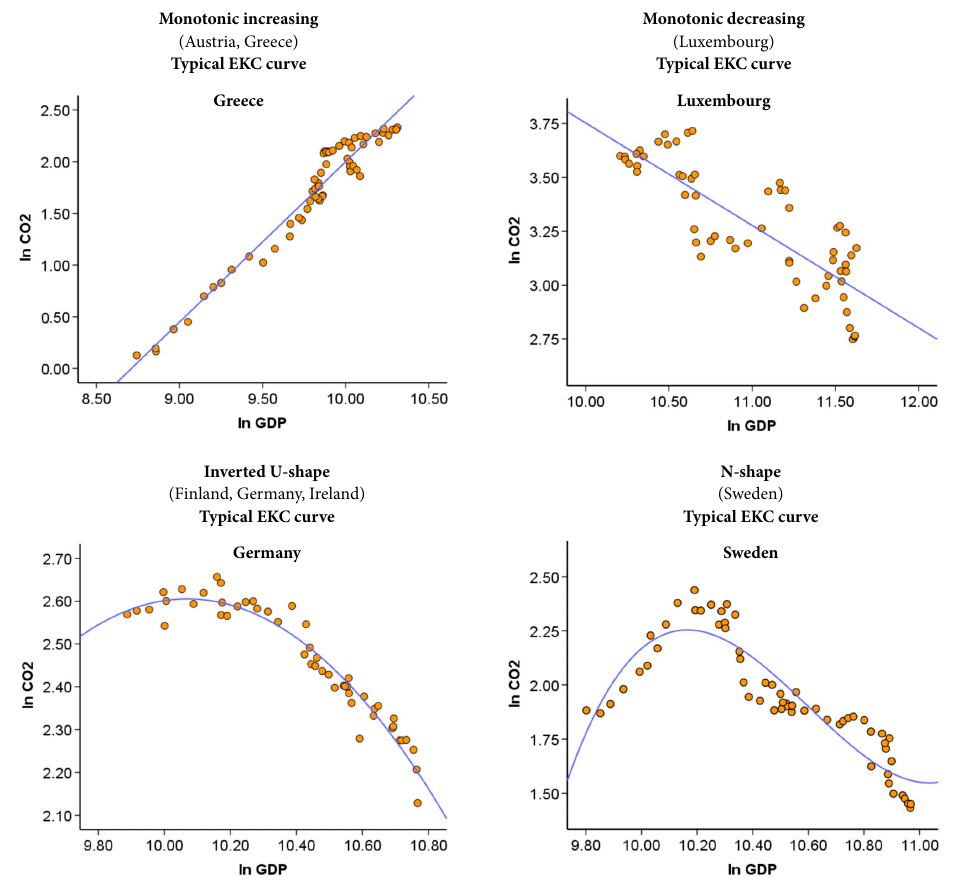
Figure 8. Groups of countries based on the EKC